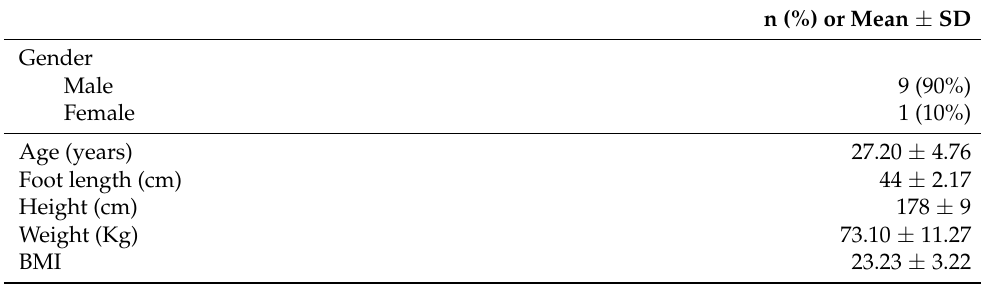
Table 1. Descriptive values of the sample.